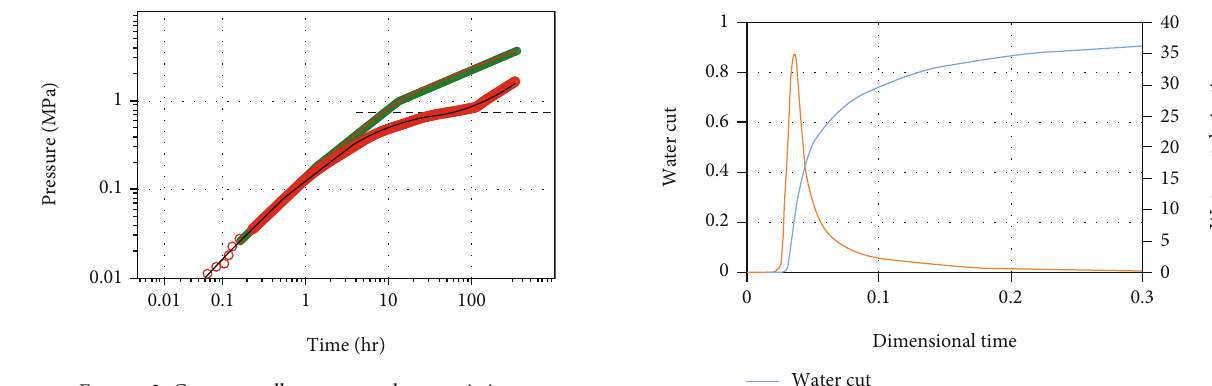
Figure 3: Current well test curve